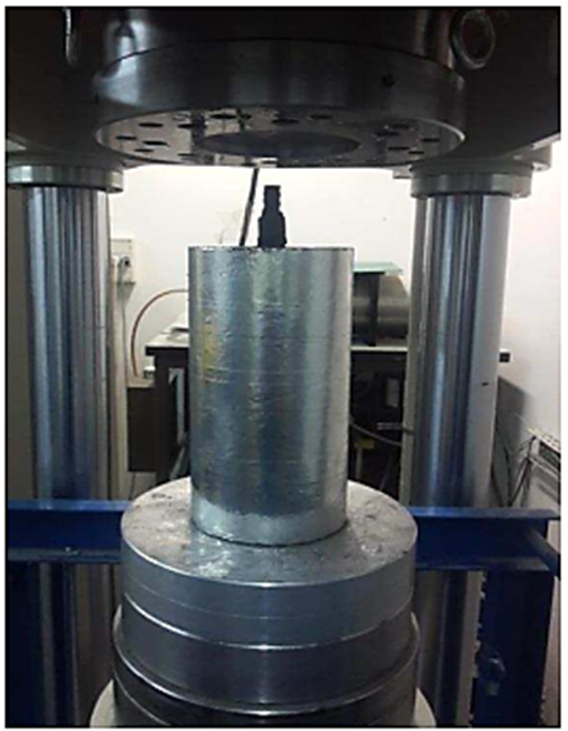
Figure 7. Push-in loading setup (adapted with permission from reference [57]).